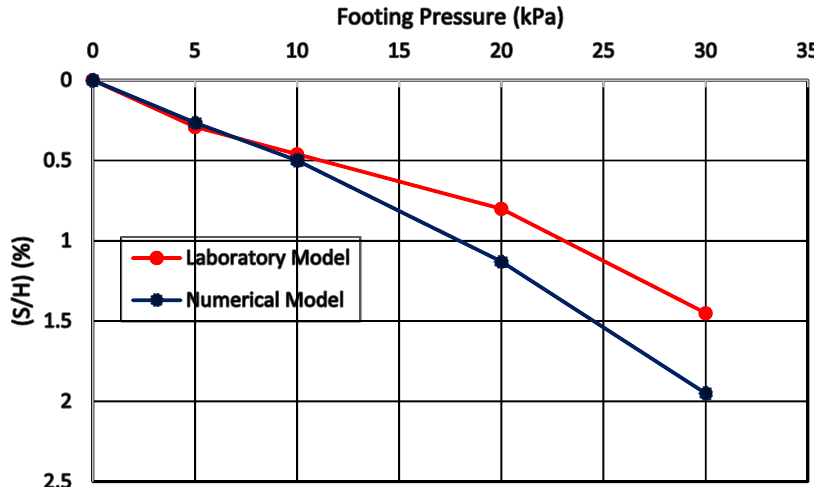
Figure 31. Footing settlement from laboratory and numerical model.